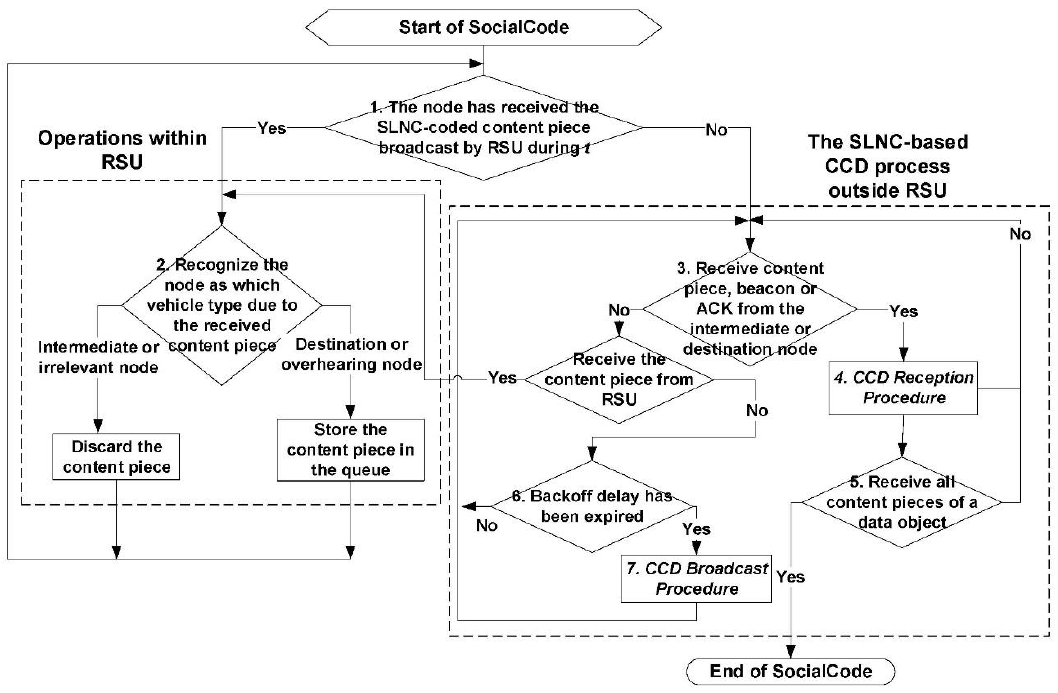
Figure 5. The main flow diagram of SocialCode.